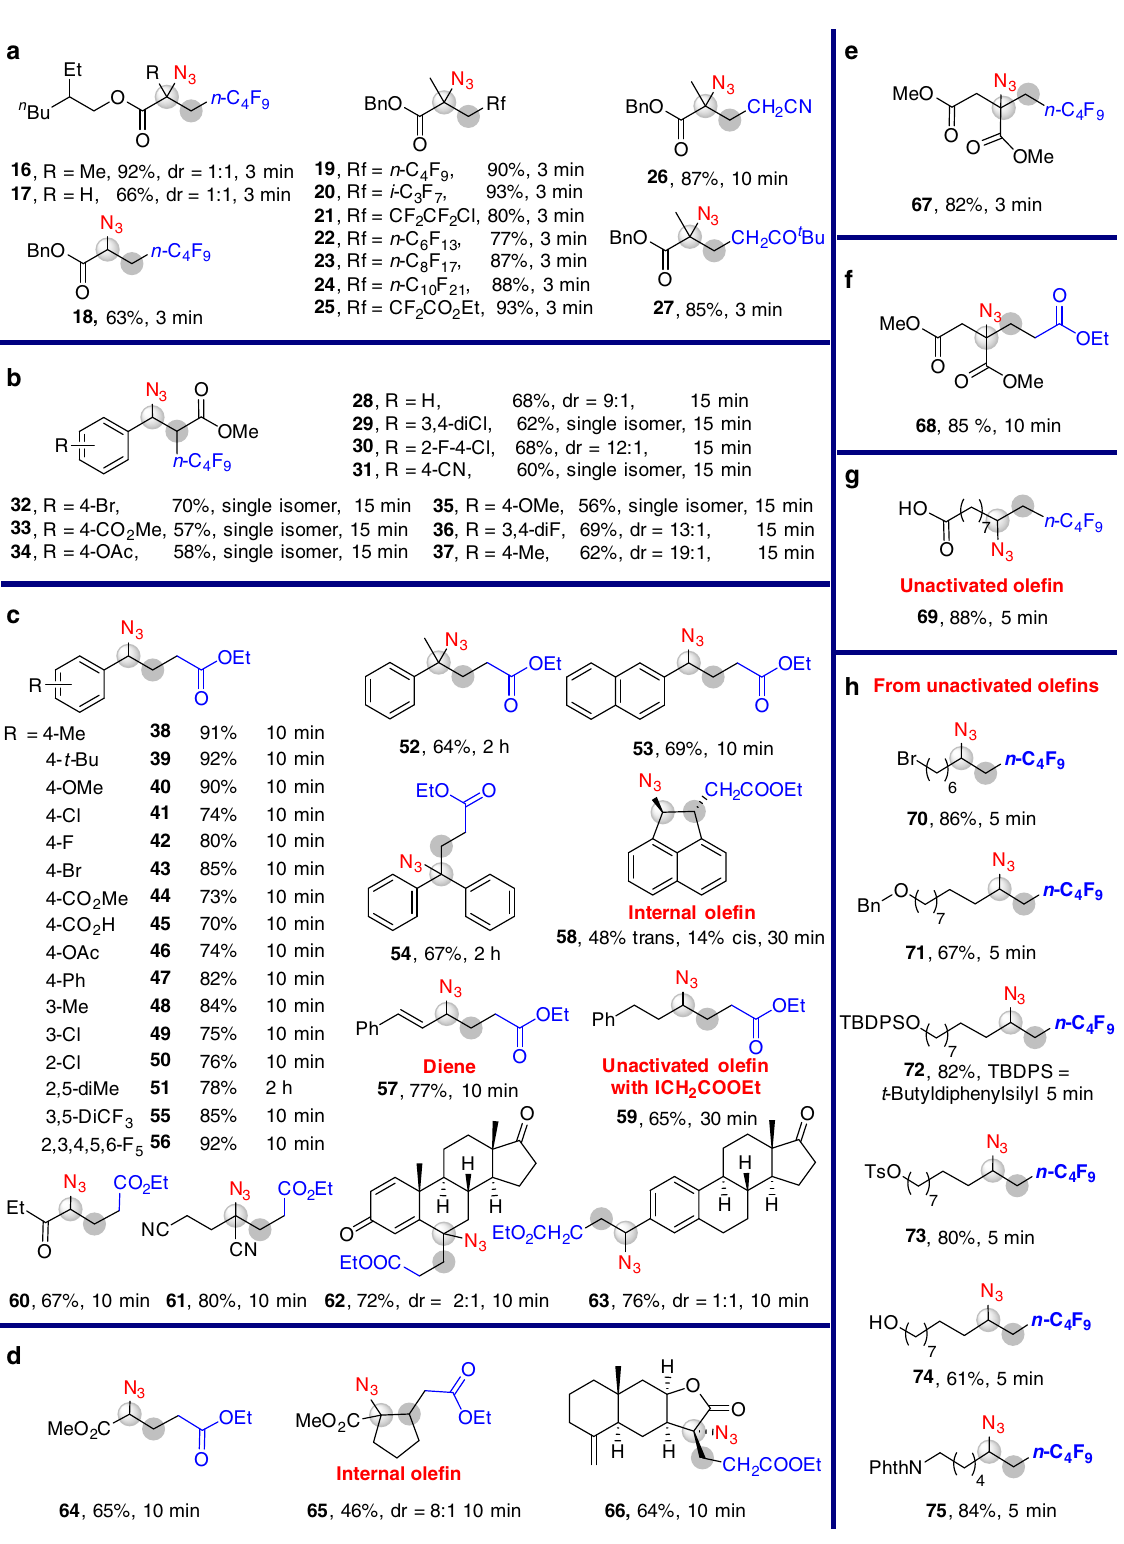
Fig. 4 Scope of alkenes. a Synthesis of α -azido esters. b Synthesis of β -azido esters. c Synthesis of γ -azido esters. d Synthesis of α , γ -azido esters. e Synthesis of an α , β -azido ester. f Synthesis of an α , β , γ -azido ester. g Synthesis of an azido acid. h Synthesis of other organoazides. General reaction conditions: Fe(OTf) 2 (5 mol%), 1 (0.5 mmol), 2 (0.65 – 1.0 mmol), TMSN 3 (1.0 mmol), TBPB (1.0 mmol) in DME (2 mL) at rt under an N 2 atmosphere. Isolated yields. dr values were determined by 1 H